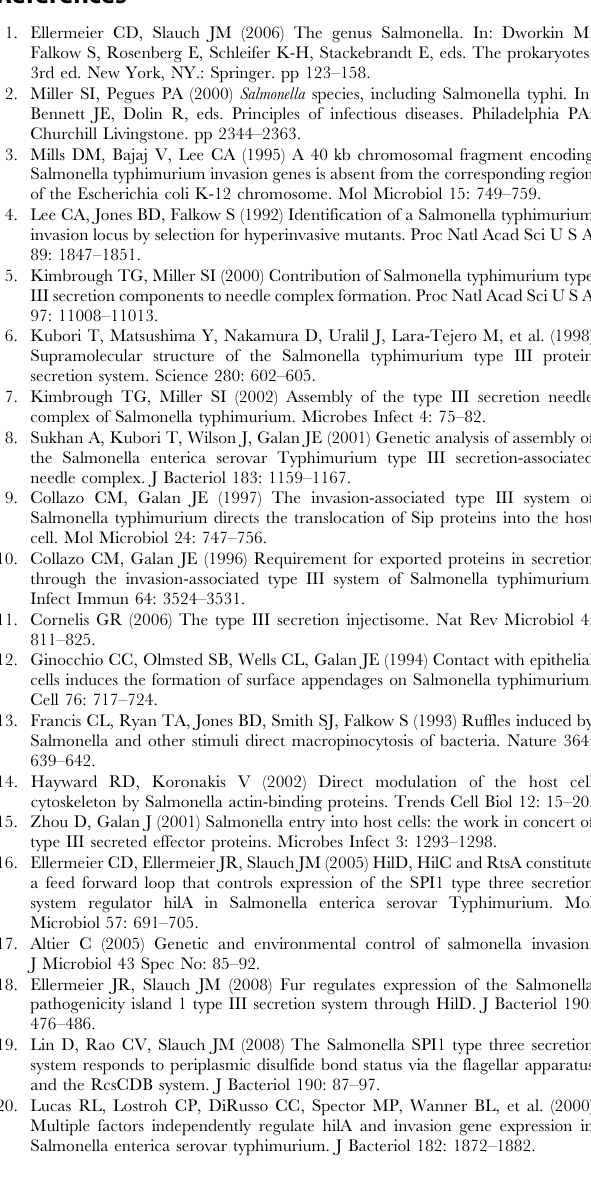
expression. Plot shows the steady-state concentration of HilD as a function of the parameters a E and a D . (D–E) Effect of HilE and HilD positive feedback on HilD (D) and HilA (E) expression. Plots shows the steady-state concentrations of HilD and HilA as a function of the parameters a E and k D . The black lines in the plots (A–C) are used to denote the results obtained using the nominal parameters (aside from a E ). A detailed description of the model is provided in the Materials and Methods. Figure S7 SPI1 promoter activities are linear correlated to one another at varying levels of induction and in different mutants. (A) Correlation of P hilD (pSS052) promoter activity with P hilA (pSS055), P hilC (pSS053), and P rtsA (pSS054) promoter activities. To induce SPI1 gene expression, cells were first grown overnight in LB/no salt and then sub-cultured into fresh LB at varying concentrations of NaCl to an OD of 0.05 and grown statically for 15 hours. Individual experiments used to construct correlations are given